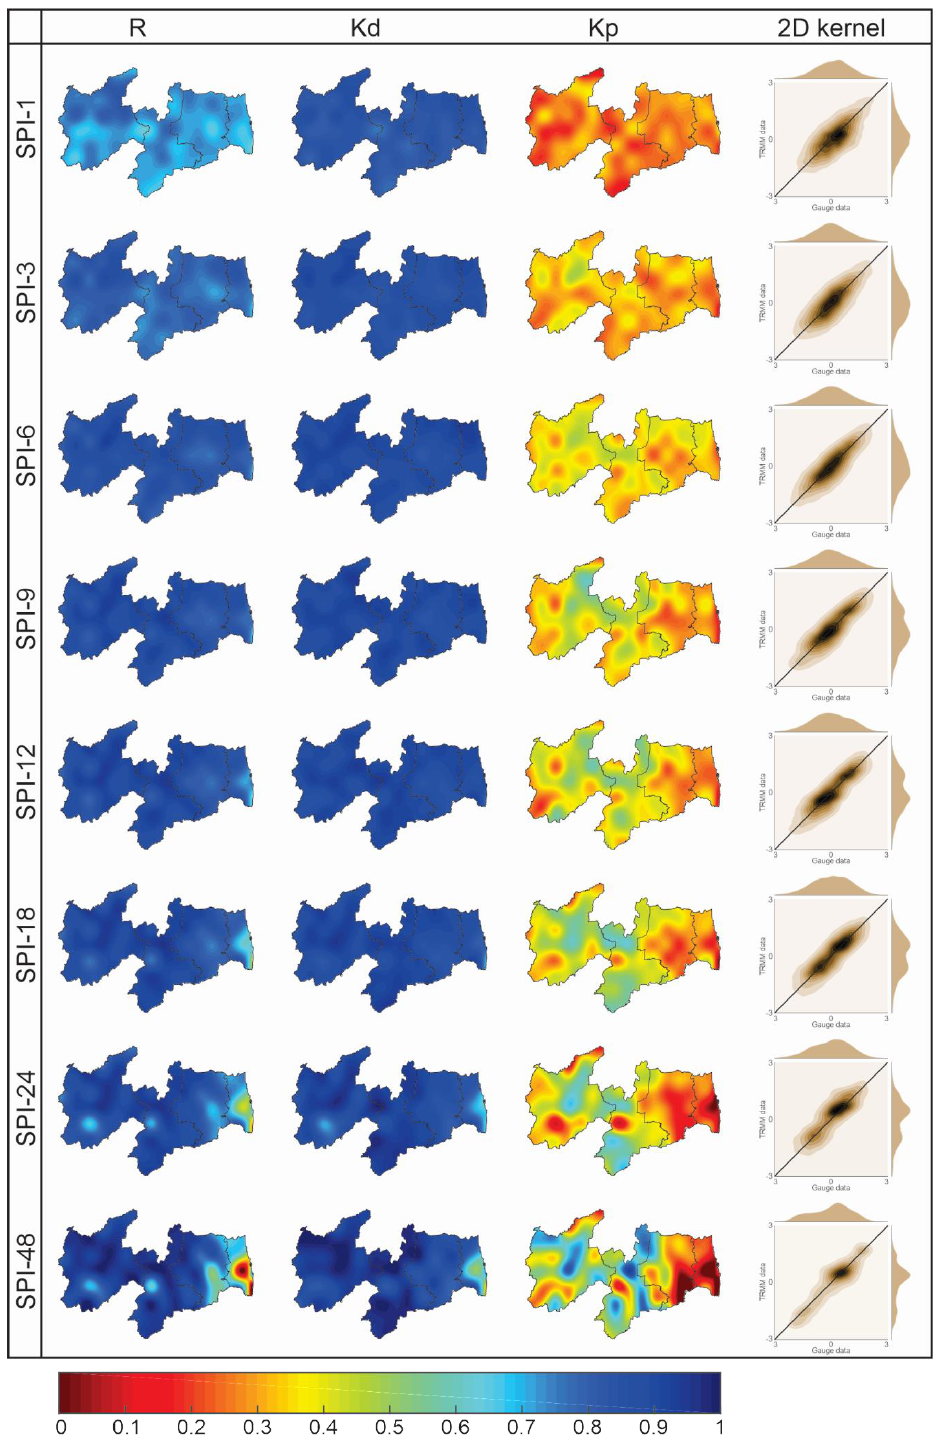
Figure 5. Spatial distribution of the R , Kd and Kp indices over Paraíba State.